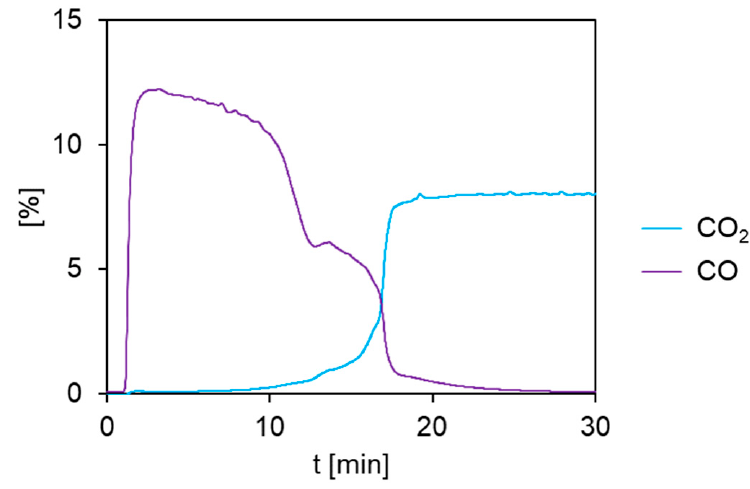
Figure 12. Catalyst regeneration at 855 °C.